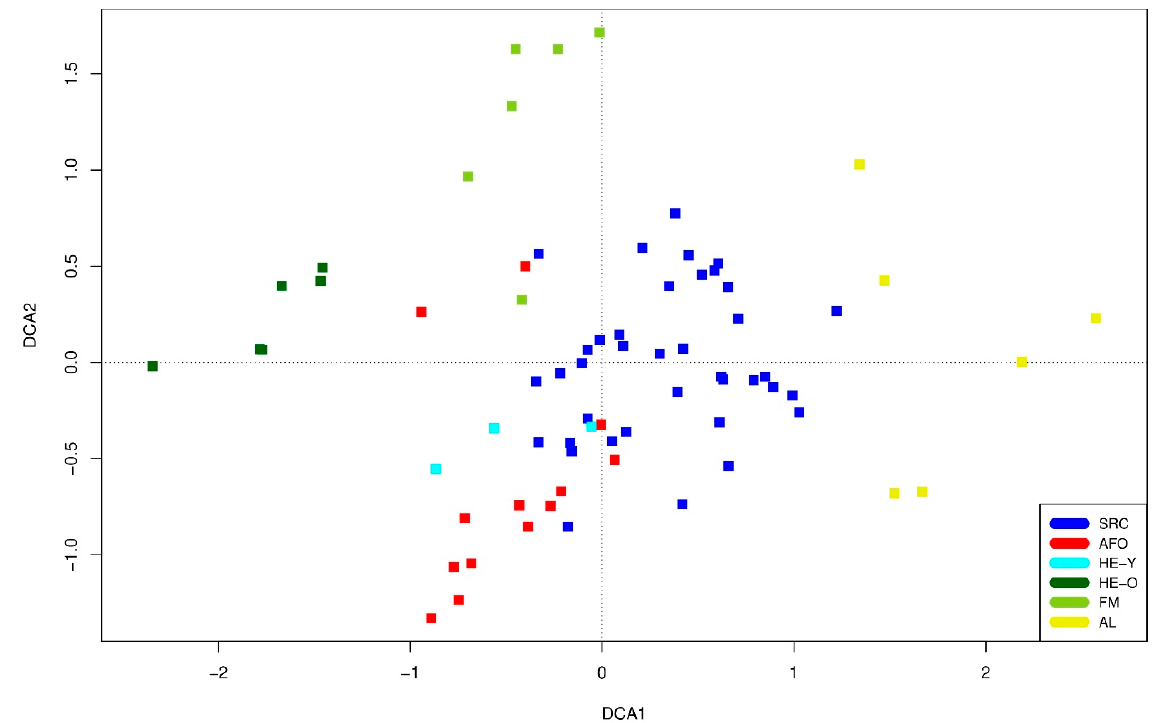
Figure 5. DCA ordination of the individual stands/sites of the different habitat types (see Table 1 for abbreviations). Eigenvalue axis 1: 0.4266, axis 2: 0.3283, length of axis 1: 4.9152, axis 2: 3.0447.